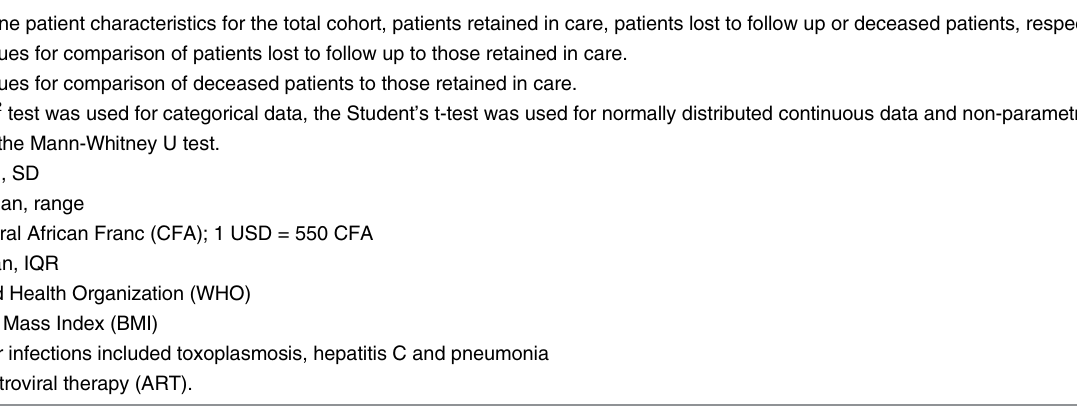
(Table 1). Patients who deceased had a higher prevalence of TB when compared to the patients that were retained in care.